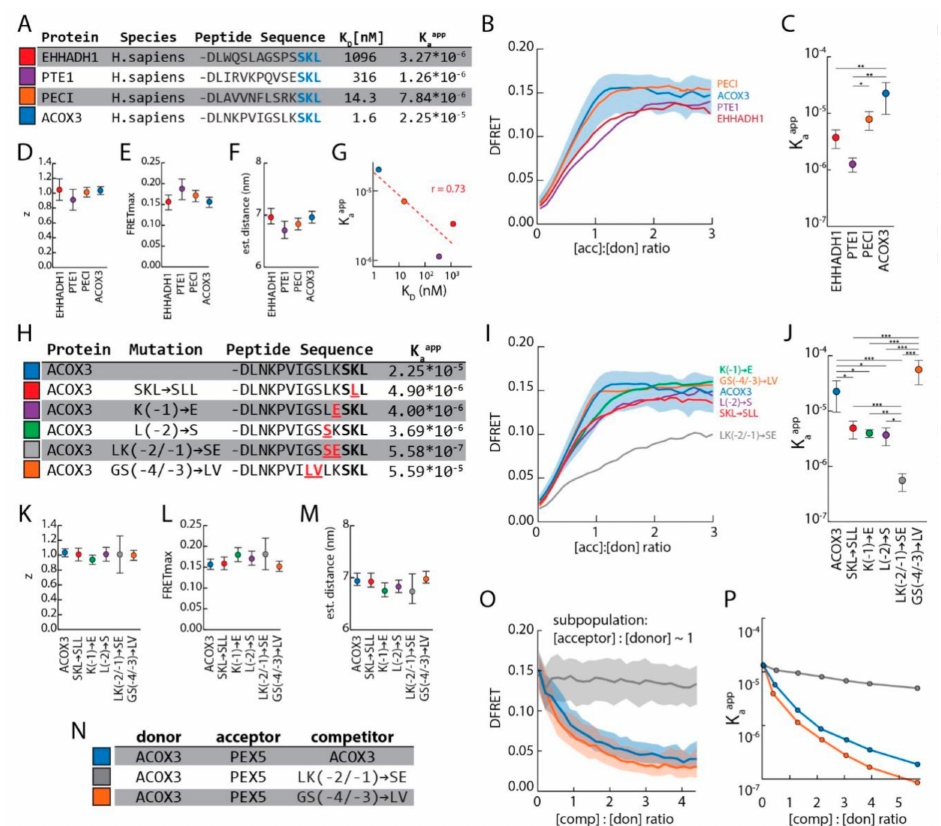
Figure 5. The upstream sequence of PTS1 motifs strongly modulates the interaction strength with PEX5: ( A ) Peptide sequences encoding PTS1 motifs of human proteins terminating with -SKL; the a ffi nity of the peptides obtained by in vitro binding experiments [16], and K aapp s obtained by FlowFRET (described below) are indicated; ( B – F ) FlowFRET measurements of pex5 − / − cells expressing mCherry-PEX5 TPR and one of the EGFP-PTS1 variants; saturation curves are depicted together with the quartiles for the PTS1 of ACOX3 ( B ); fitting the data sets allowed the extraction of K aapp ( C ), z ( D ) and FRET max ( E ), from which the distance between mCherry and EGFP was predicted ( F ); ( G ) correlation between the apparent interaction strength obtained by in vitro peptide binding assays (depicted as K D ) or by FlowFRET (depicted as K aapp ); ( H ) peptide sequences encoding the PTS1 of human ACOX3 and variants thereof; K aapp s obtained by FlowFRET (below); ( I – M ) FlowFRET experiment studying the interaction between PEX5 TPR and ACOX3 mutants; ( I ) saturation curves were obtained as before and quartiles for the PTS1 of ACOX3 are indicated; fitting the data sets allowed the extraction of K aapp ( J ), z ( K ) and FRET max ( L ), and the distance between mCherry and EGFP in the complex was calculated ( M ). ( N–O ) Live-cell competition to investigate the interaction between PEX5 TPR and three PTS1 of ACOX3 variants: FlowFRET experiments of pex5 − / − cells expressing mCherry-PEX5 TPR and EGFP-PTS1 (ACOX3) together with one of the Cerulean-PTS1 variants (ACOX3 (blue), ACOX3- -4 GS -3 / LV (grey) or ACOX3- -2 LK -1 / SE (orange) ( N )) were performed as described before; ( O ) decay of DFRET values with increasing competitor-to-donor ratios using cells with an acceptor-to-donor ratio of around one (0.8 < x < 1.2) and ( P ) reduction in K aapp , when di ff erent populations of competitor-to-donor ratios are fitted independently. Statistics: One-way ANOVA for log 10 of K aapp ( C ), z ( D ) and FRET max ( E ), (( C – F ): three independent experiments, mean ± sdv); one-way ANOVA for log 10 of K aapp ( J ), z ( K ) and FRET max ( L ), (( I – M ): n = 4); ( N – O ): n = 105,306 (ACOX3), 105,135 (LK / SE) and 127,442 (GS / LV); *** p < 0.001, ** p < 0.01, * p < 0.05, Description: ( B , I ) Lines represent binned average, shaded area represents